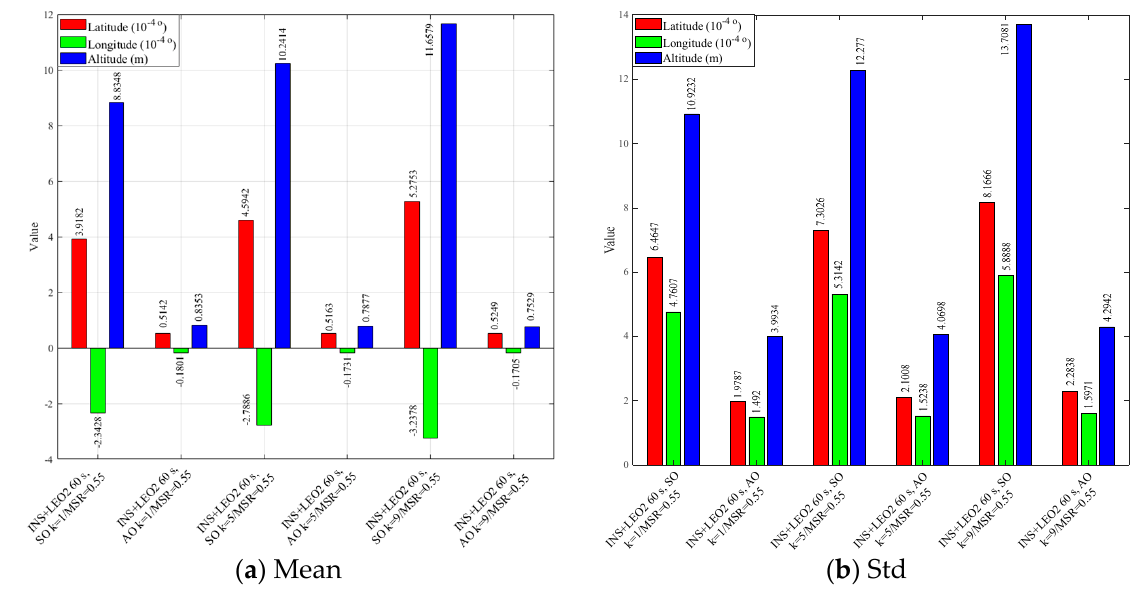
Figure 13. Error statistics.